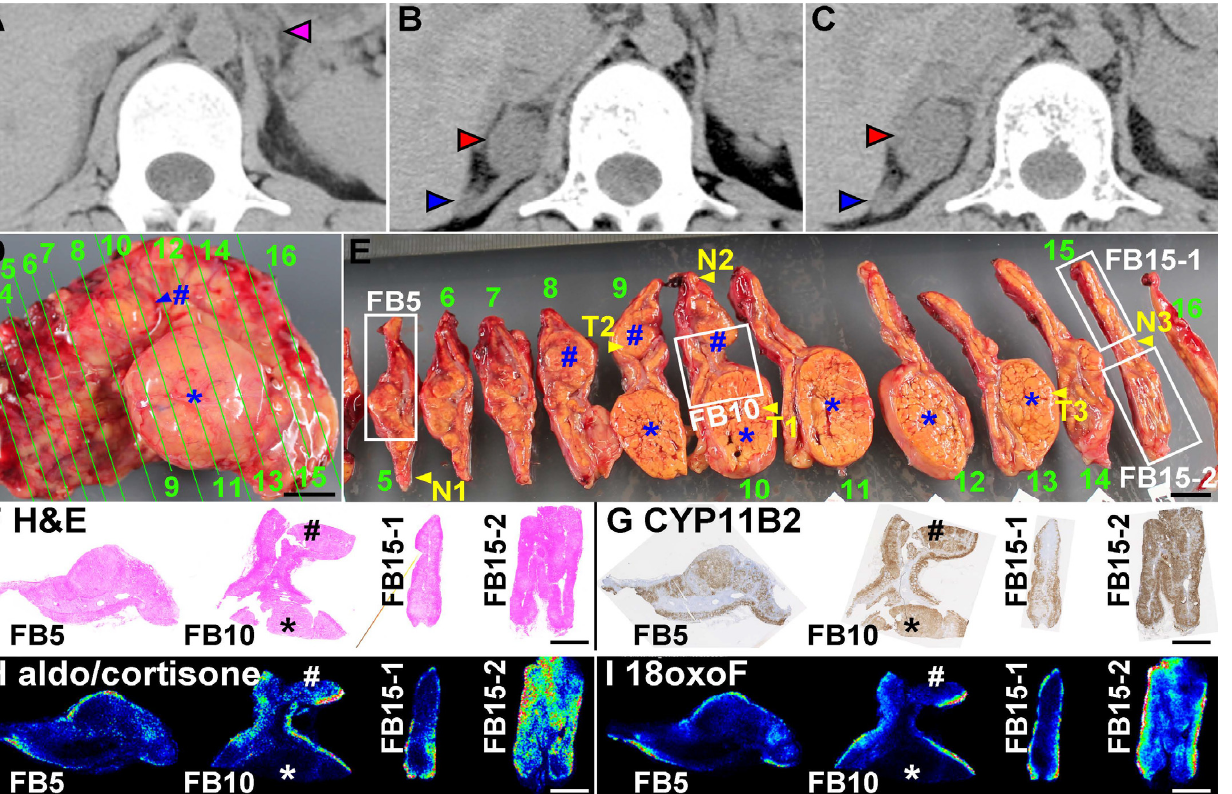
Figure 1. CT and histological findings of the case. ( A ) CT findings at 15 years of age. The left adrenal gland was removed after CT examination. ( B ) CT findings at 26 years of age. Red and blue arrowheads indicate the larger and smaller adrenal tumors in the right adrenal gland, respectively. ( C ) CT findings 4 months after the CT shown in panel B. The larger tumor significantly enlarged in 4 months. ( D ) Macroscopic findings of the extracted right adrenal. The larger (*) and the smaller (#) tumors presumably corresponded to the large (red arrowhead) and small (blue arrowhead) tumors in panels (B) and ( C ), respectively. The adrenal was cut into 16 pieces at the green lines. ( E ) Cut surfaces of the extracted adrenal. The green numbers in panel ( D ) correspond to the numbers in panel ( E ). The cut surface numbers in panels ( D , E ) correspond to those in parentheses in Supplementary Figure S1, which shows the sections after formaldehyde fixation. Frozen tissue blocks, in an optimal cutting temperature compound, were prepared from 4 portions, indicated by white frames (FB5, FB10, FB15- 1, and FB15-2). Flash frozen tissues were also taken from 3 non-tumor portions (N1–N3) and 3 tumor portions (T1–T3). ( F – I ) Hematoxylin and eosin staining, immunohistochemistry for CYP11B2, MALDI-imaging of aldosterone and cortisone (aldo/cortisone), and that of 18-oxocortisol (18oxoF), respectively, of frozen tissues.